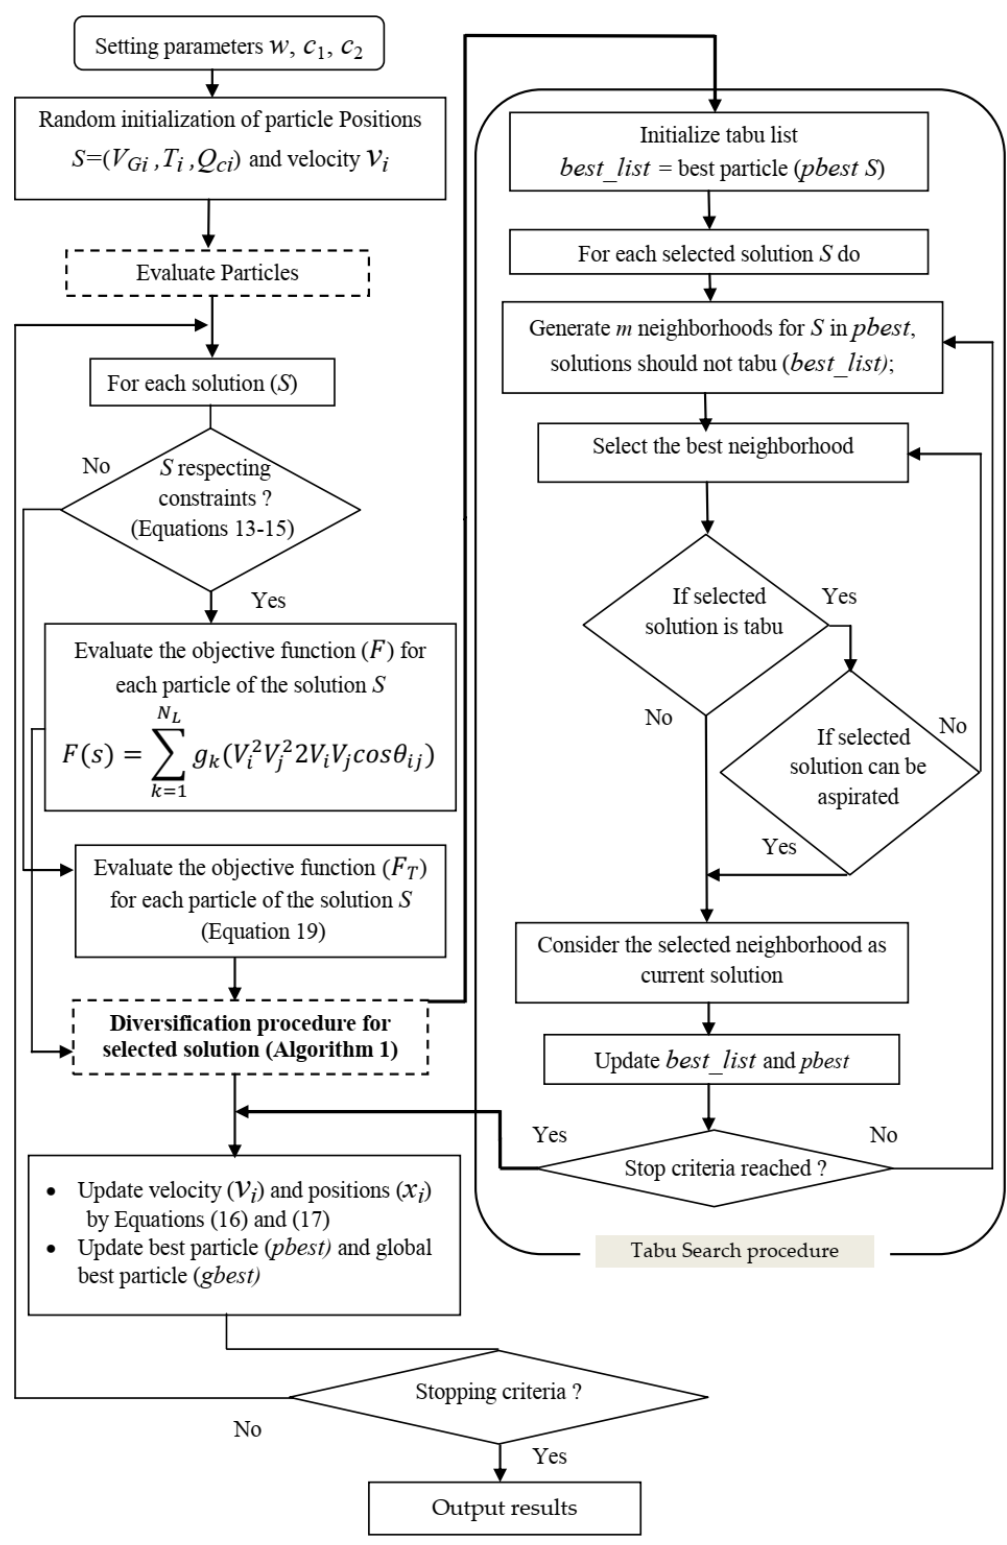
Figure 3 . Detailed flowchart of the PSO-TS method. Figure 3. Detailed flowchart of the PSO-TS